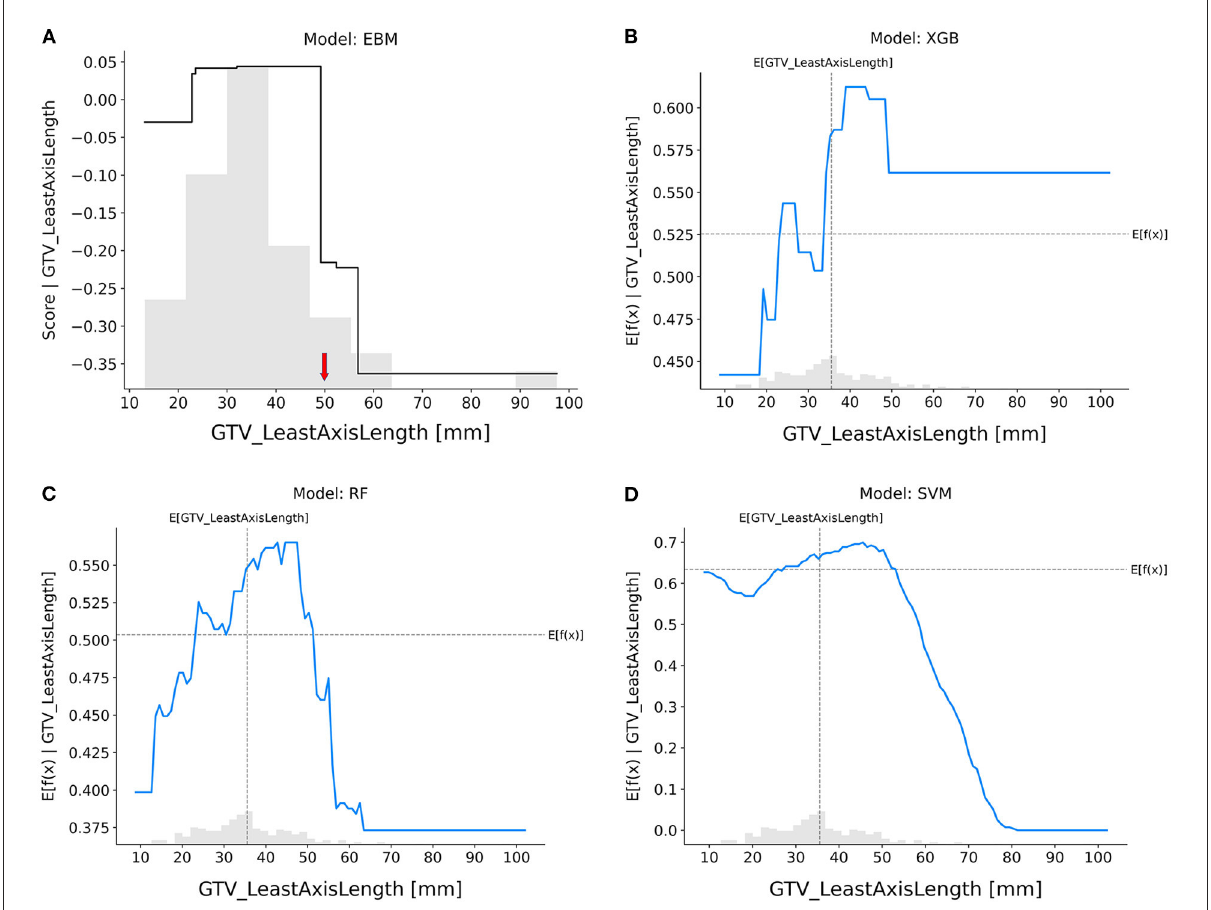
FIGURE7 Response score plots for GTV_leastAxisLength. (A) EBM shape function and SHAP partial dependence functions for the (B) XGB, (C) RF, and (D) SVM